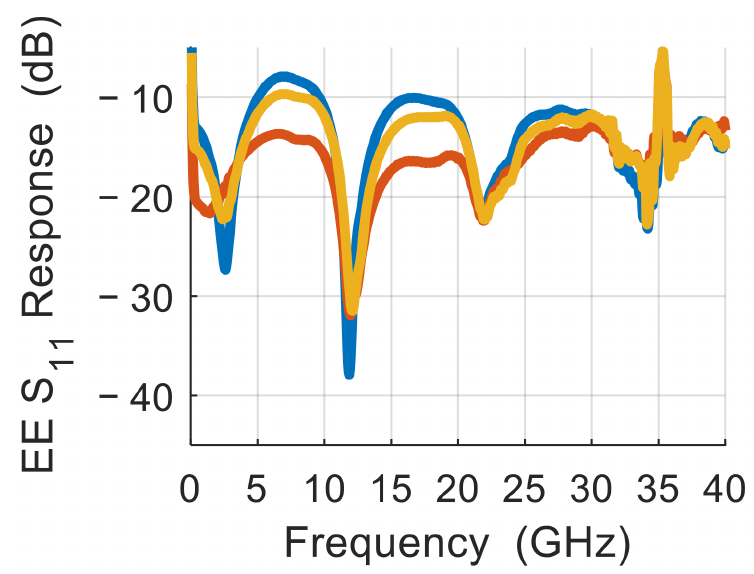
Figure 3. Representative S 11 response (best: red; intermediate: yellow; worst: blue).